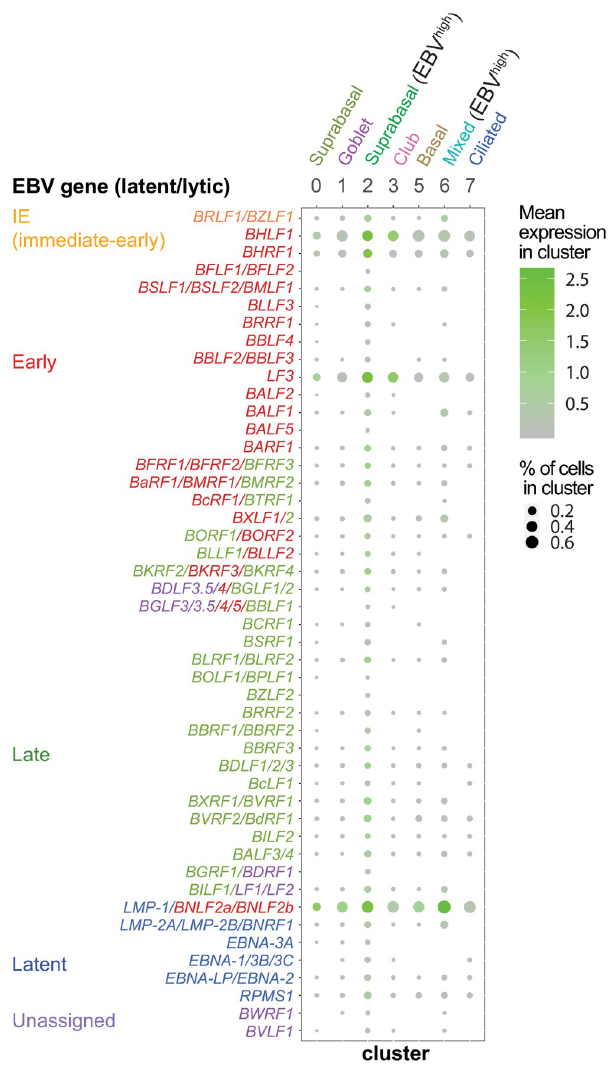
Fig 7. Averaged expression of EBV genes by cluster. Dot plot shows expression of EBV genes for epithelial cell clusters in the EBV-infected pseudo-ALI culture of donor no. 4. Genes are grouped in latent or lytic (immediate-early/ early/late). Unassigned genes are in purple. Mean expression by cluster shows log10 transformed pseudocount (UMI count+1) for EBV gene averaged by cluster. Dot size indicates the percentage of cells in each cluster expressing the EBV gene. The scRNA-seq reads were aligned to the EBV genome fused annotation.